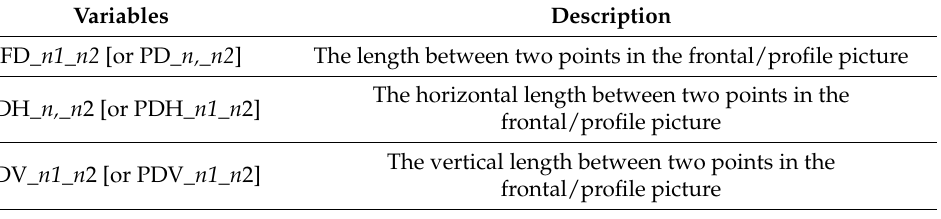
Table 2. Descriptions on facial landmarks’ variables